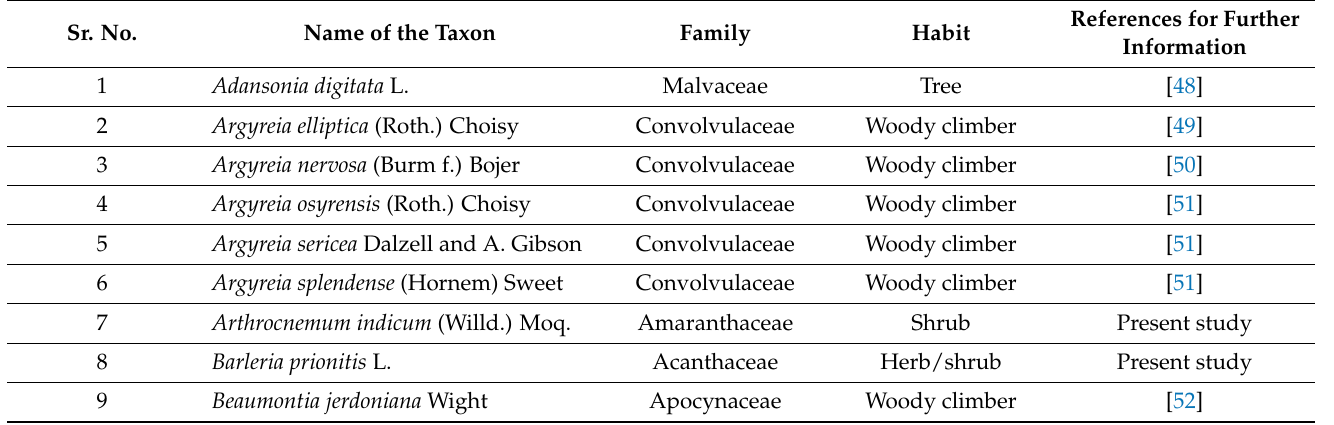
Table 1. The list of species investigated in the present study. The methods of sample analysis are discussed in the references cited in the last column. A similar method is also used for those species where the term ‘present study’ is